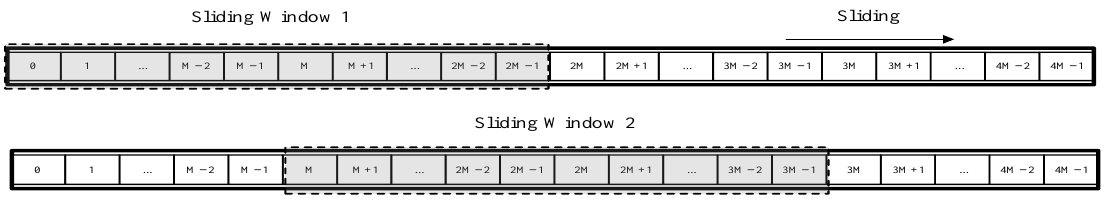
Figure 6. Sliding Figure 6. Sliding Windows.